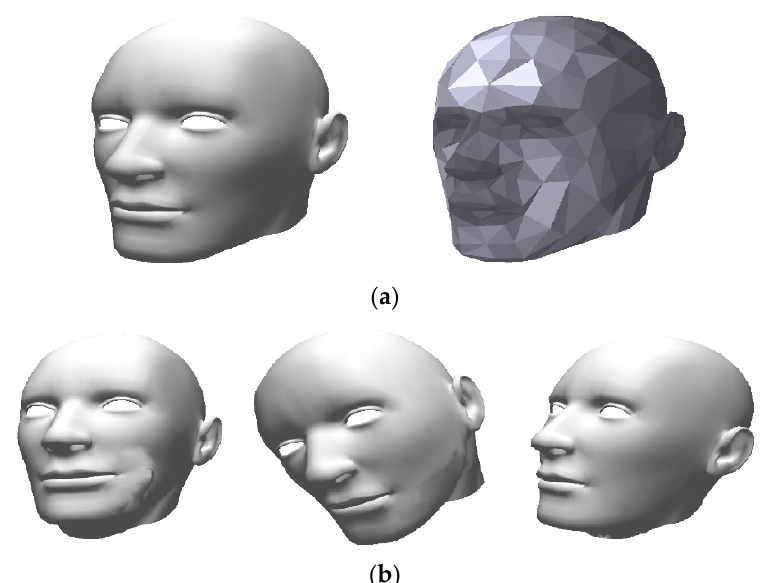
Figure 3. Human head model: ( a ) Geometry and the surface representation of the FE mesh; ( b ) screenshots from an interactive simulation [72].